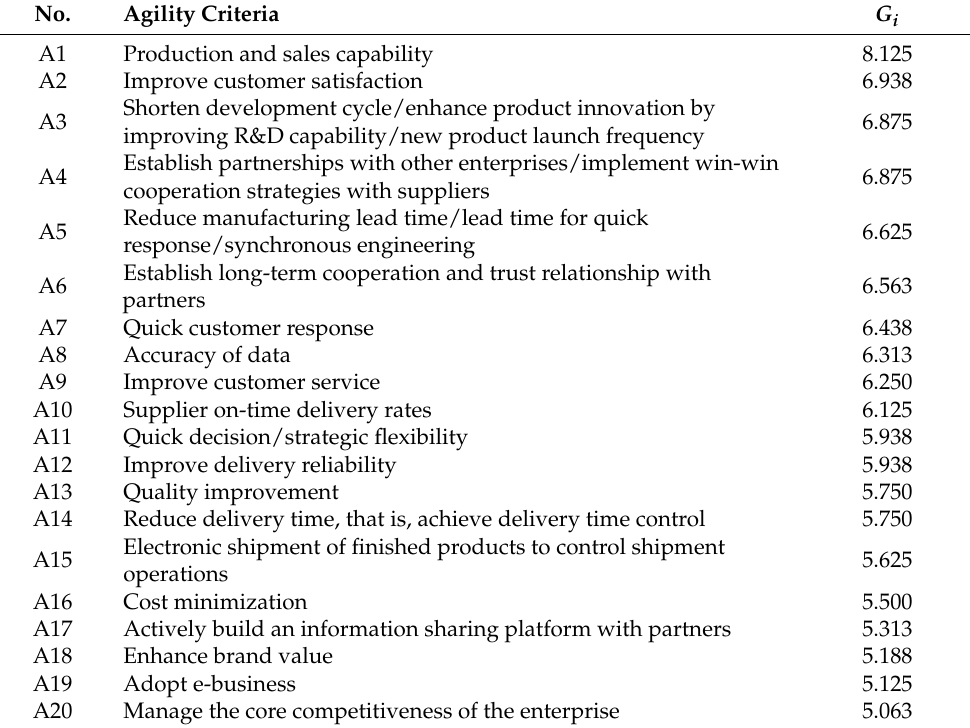
Table 4. Key agility criteria after